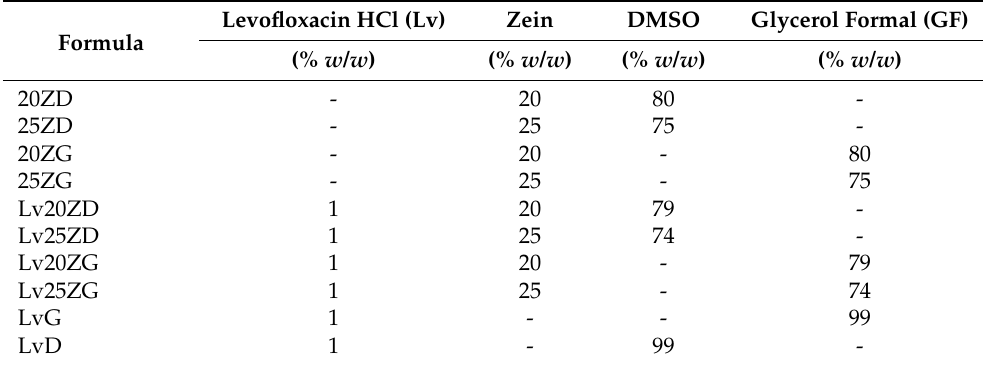
Table 1. Composition of Lv-loaded zein-based ISG